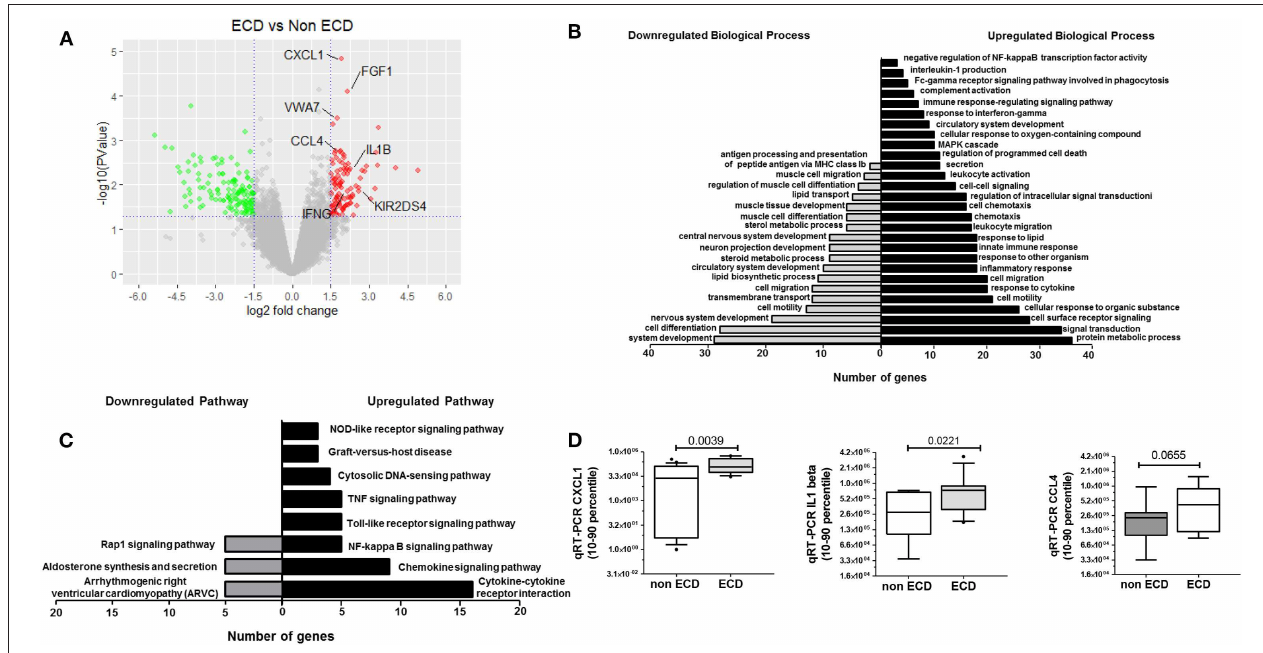
FIGURE 3 | Comparative Transcriptomic analysis of SVF from ECD ( n = 5) and non-ECD ( n = 5) patients. (A) Volcano plot of differentially expressed genes from SVF from ECD and non-ECD. Log2 Fold Change value obtained by RNAseq plotted against the –log10 of P -value. Genes with a fold change > |1.5| and P < 0.05 were deemed to be differentially expressed. P = 0.05 is indicated by horizontal lines. Positive and negative fold change values are reflective of down-regulated (green) or up-regulated (red) genes compared with non-ECD condition, respectively. (B) Fold enrichment over chance for the Gene Ontology Biological process of the Down (gray) and Up (black) gene lists using DAVID (fold change > |1.5| and P < 0.01). (C) Fold enrichment over chance for the KEGG Pathway of the Down (gray) and Up (black) gene lists using DAVID (fold change > |1.5| and P < 0.01). (D) qRT-PCR validation of selected genes expressed a relative levels of specific transcripts detected per 10 6 GAPDH transcripts [median (25–75%